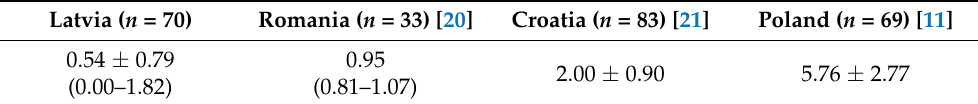
Table 5. Trans fatty acid intake (g per day) among lactating women. Data from different